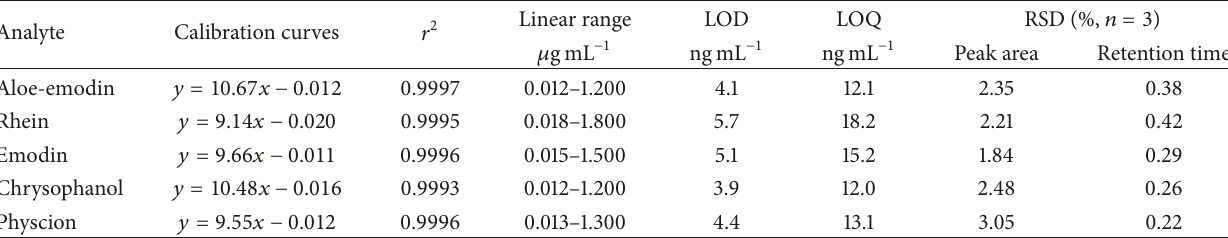
Table 1: Analytical performance data of the proposed method.